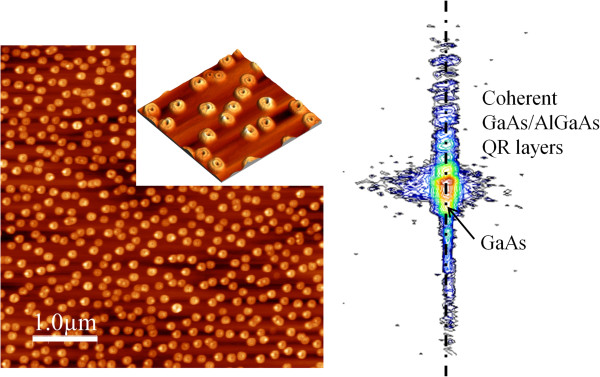
AFM images of surface (left) and reciprocal space map of GaAs/Al0.33Ga0.67As quantum ring solar cell (right).